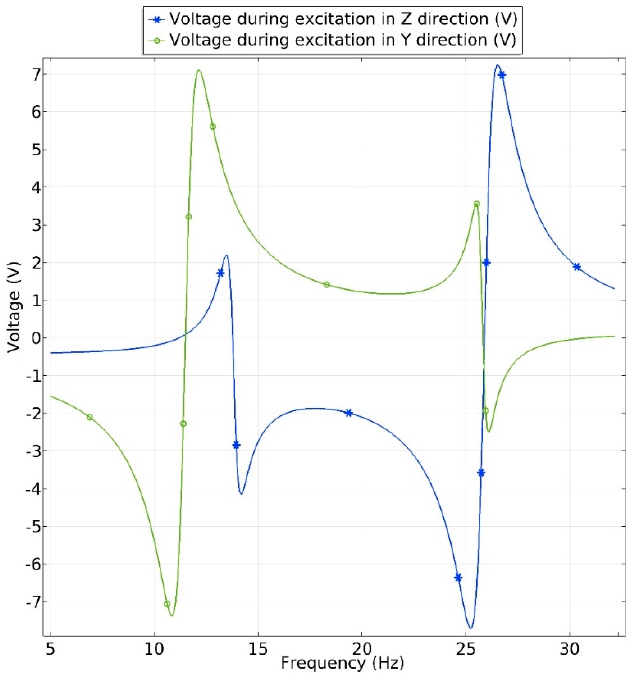
Figure 12. Total output voltage of bidirectional energy harvester.